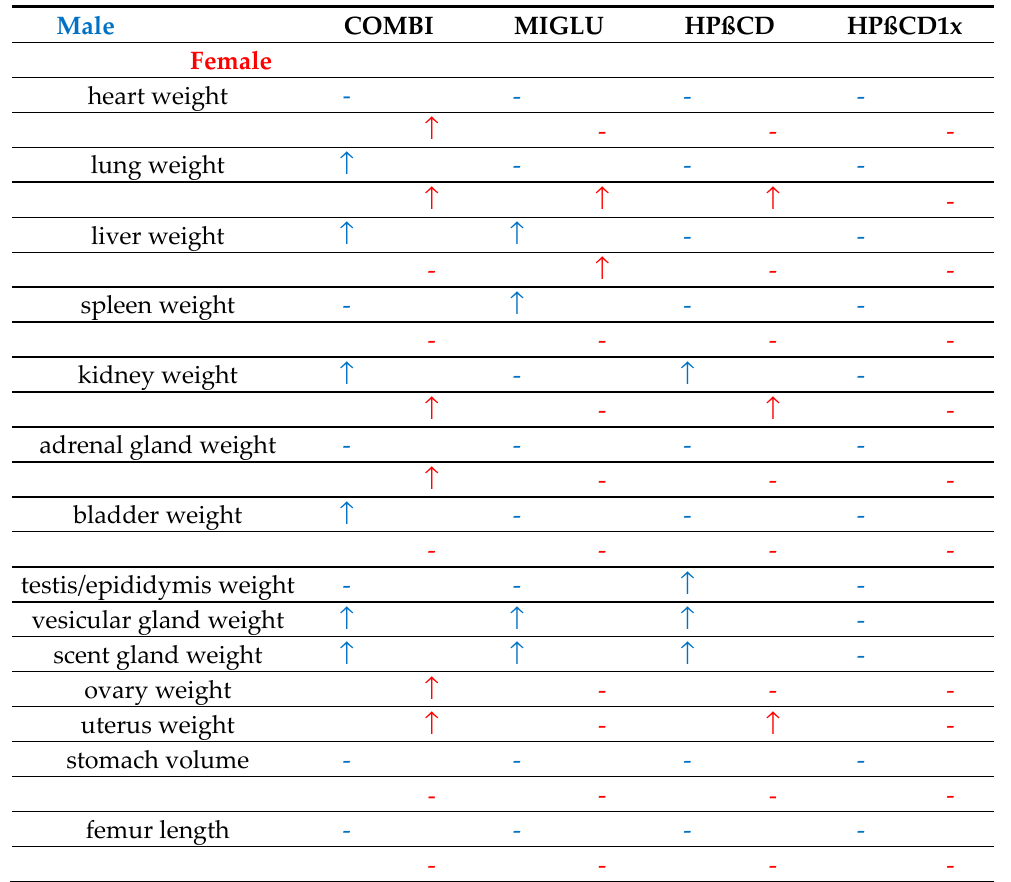
Figure 20. Changes of the absolute organ weights, volumes, or lengths, induced by COMBI, MIGLU, HPßCD, and HPßCD1x in male and female Npc1 − / − mice. Significant amelioration ( ↑ ) or no signifi- cant change (-) compared with the respective None groups.